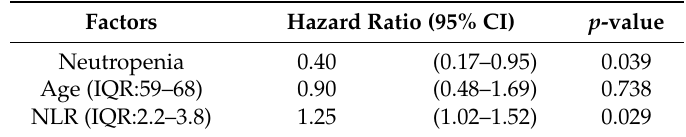
Table 2. Cox proportional hazard analysis of time varying neutropenia associated with overall survival in advanced pancreatic cancer patients receiving modified FOLFIRINOX therapy.